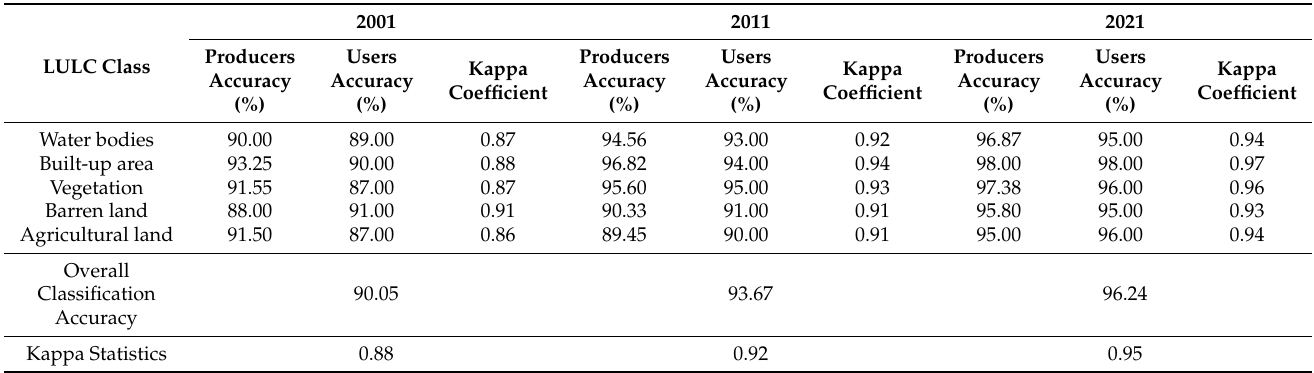
Table 3. Accuracy assessment using the Kappa statistics of the classified LULC maps for three